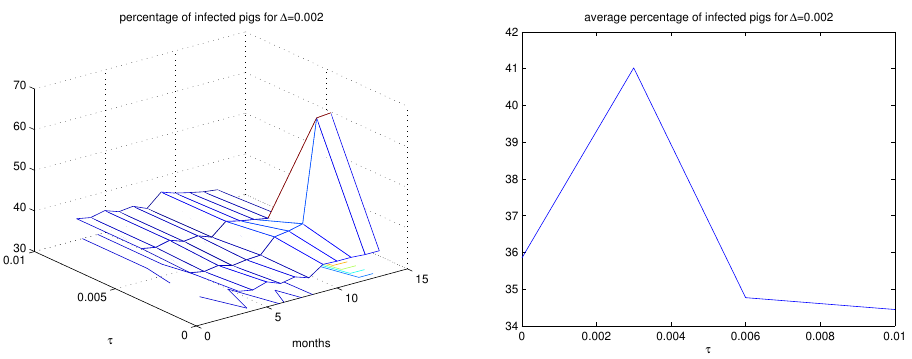
Fig. 12 Left: Percentage of infected pigs evolution in the fattening unit. Here we fix the value of biohazard rate at ∆ = 0 . 002. Right: Averages in time as function of τ of the percentage of infected pigs evolution in the fattening unit. Here we fix the value of biohazard rate at ∆ = 0 .